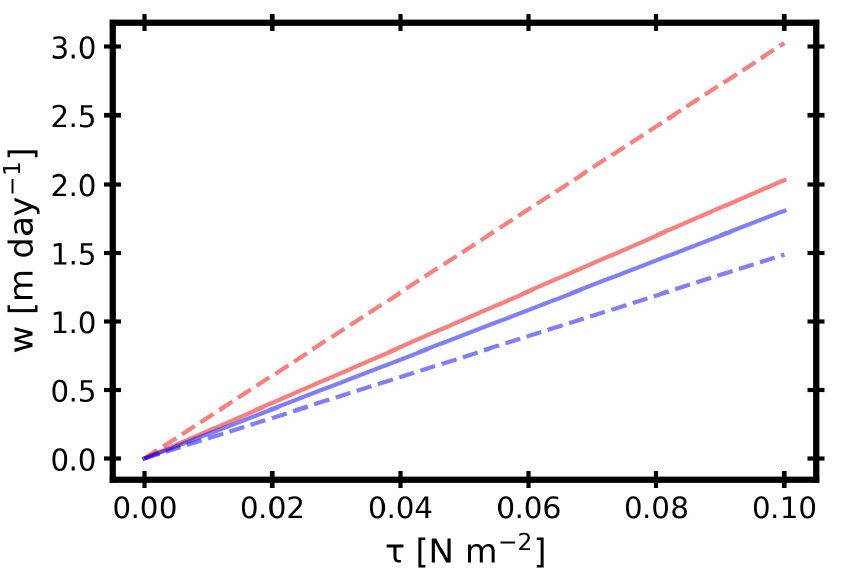
Figure 17. Maxima of the nonlinear (dashed) and linear (solid) Ekman pumping for the CE (red) and the AE (blue), in regards to the magnitude of the wind